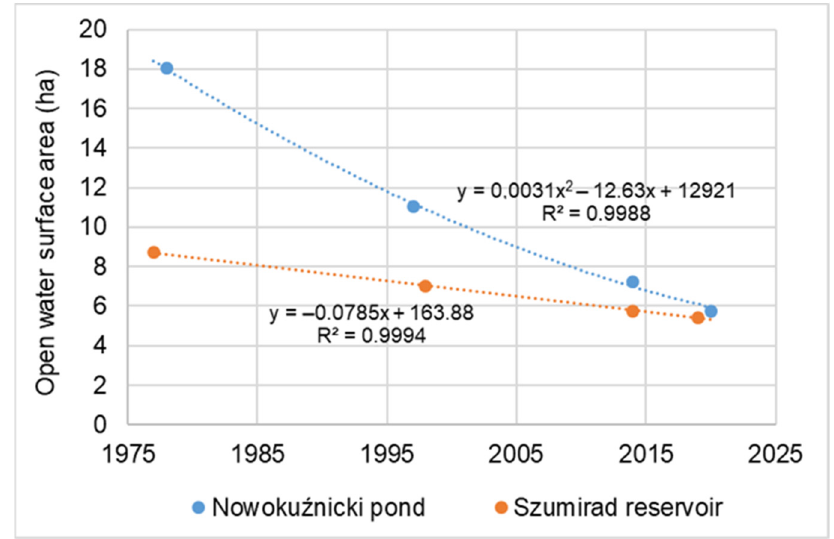
Figure 4. The rate of disappearance of the analyzed reservoirs as a result of the process of land formation. Table 2. The conservation status of the Trapa natans population in the analyzed ponds in 2014. Assessment: proper (FV), unsatisfactory (U1).